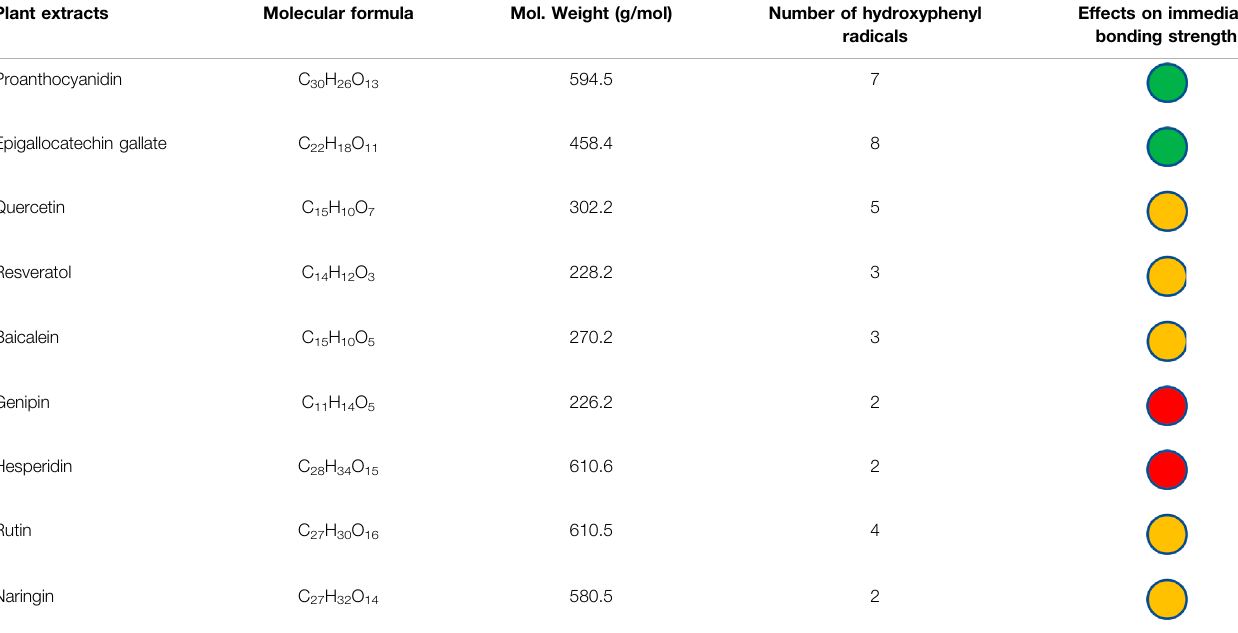
Green = evident; Yellow = unclear; Red = not